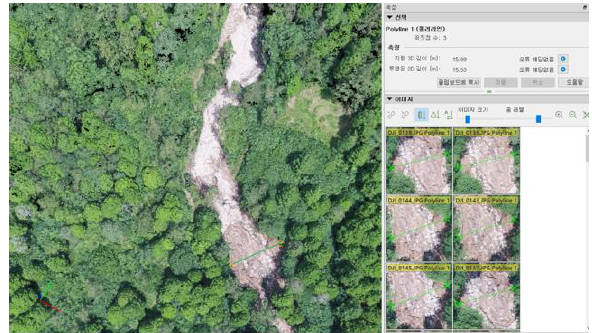
Figure. 6. Landslide damage analysis using drone